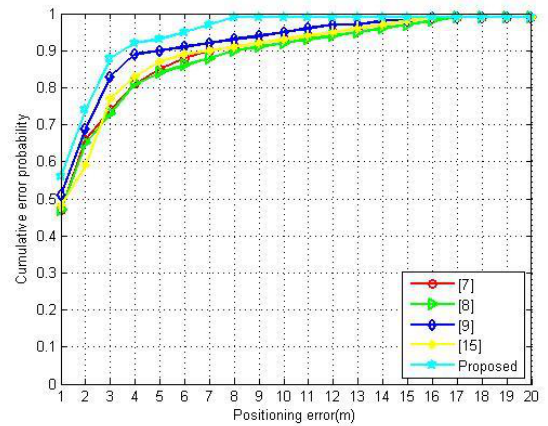
Figure 7. The positioning errors using different methods.